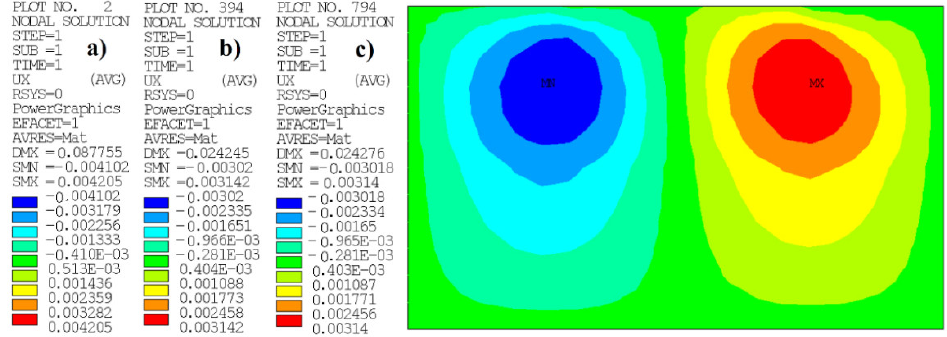
Figure 9. Distribution of the displacement U x below the footing at ( a ) 4.385, ( b ) 434.115, and ( c ) 872.615